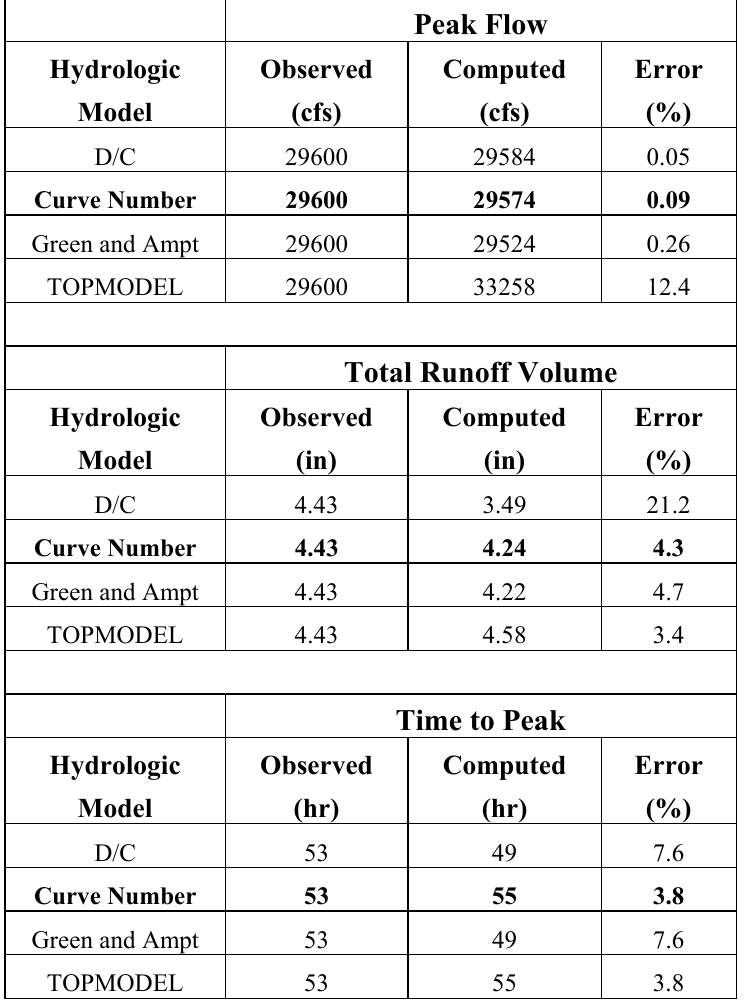
Table 1. Runoff error statistics for calibrated models based on WSR-88D Stage-III radar rainfall data. Error is defined as the difference in observed and modeled value and expressed as a % relative to the observed